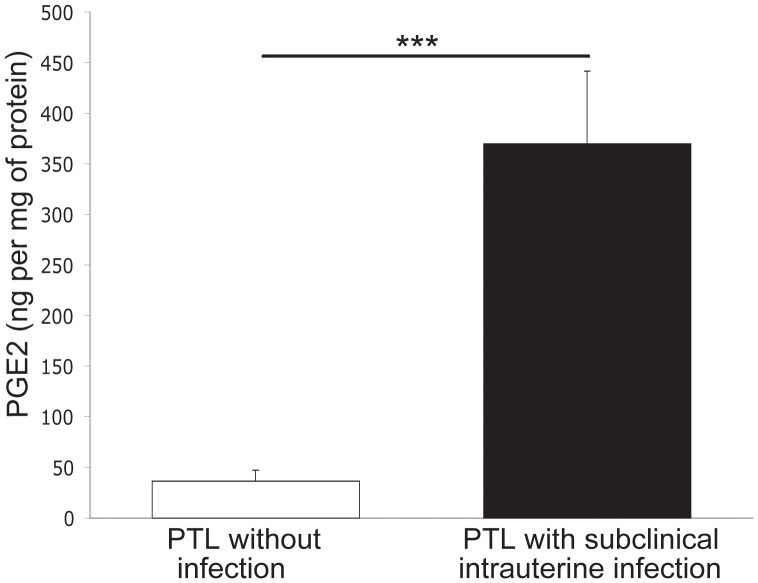
Prostaglandin E2 secreted by cultured decidual cells from women with and without subclinical intrauterine infection.Concentrations of prostaglandin E2 in the supernatants of decidual cell cultures from women with preterm labor (PTL), with (n = 10) or without subclinical intrauterine infection (n = 25). Data are presented as mean±SD; experiments were performed in duplicate. ***P<0.001.